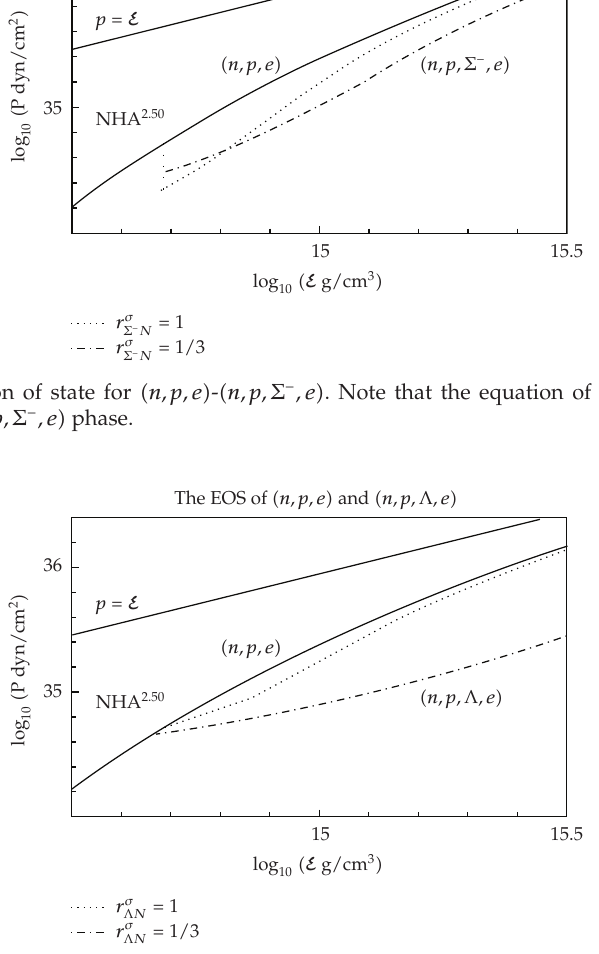
Figure 6: The equation of state for Λ from (cid:7) n,p,e (cid:8) to (cid:7) n,p, Λ ,e (cid:8) . The EOS for r σ Λ (cid:7) n,p, Λ ,e (cid:8)